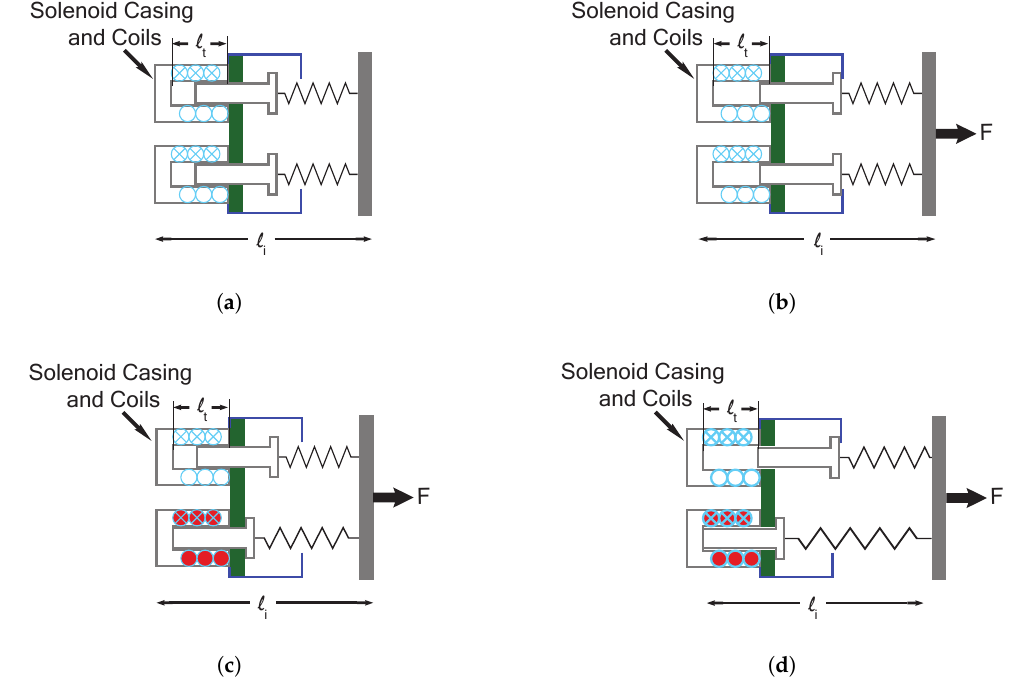
Figure 5. Variety in arrangements of actuators: ( a ) Class Zero; ( b ) Class I; ( c ) Class II; and ( d ) Class